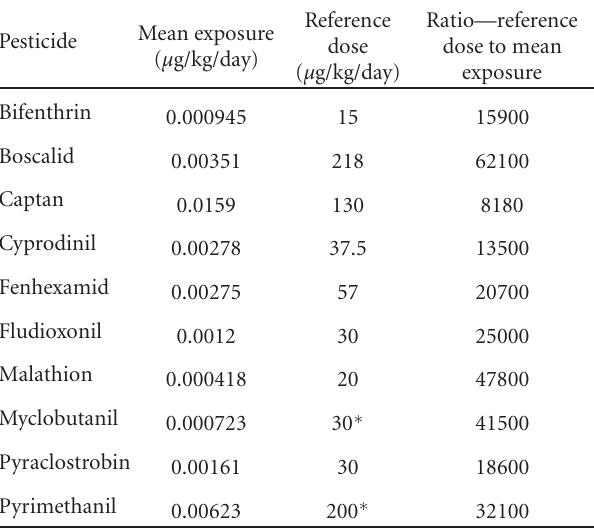
Table 13: Exposure estimates of the ten most frequently detected pesticides on